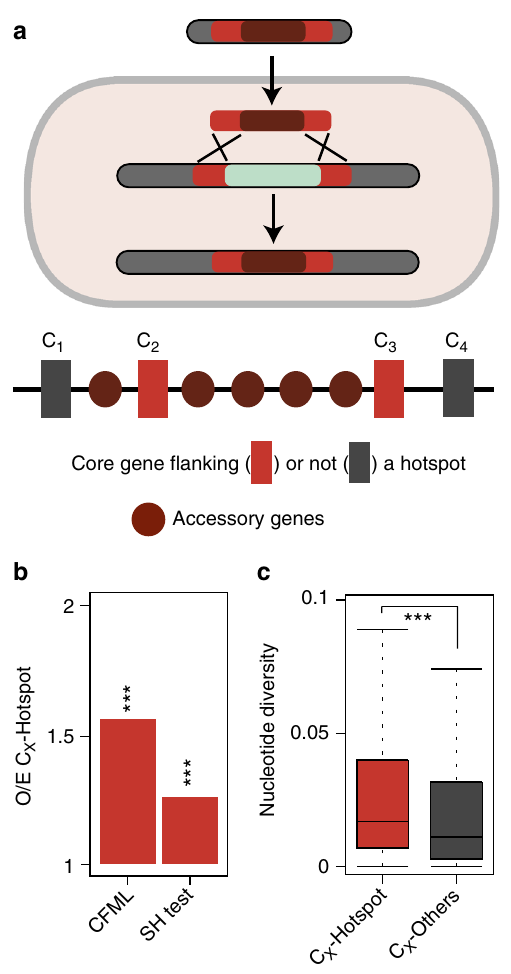
Fig. 8 Evidence for more frequent homologous recombination in core genes fl anking hotspots than in the other core genes. a Model for the creation and evolution of hotspots by homologous recombination at the fl anking core genes. b We detected homologous recombination events in the core genes using ClonalFrameML, and searched for evidence of phylogenetic incongruence ( P < 0.05) between each core gene family and the whole core genome tree of the clade using the Shimodaira – Hasegawa (SH) test. The observed – expected ratios (O/E) for these two analyses are signi fi cantly higher than one. *** P < 10 − 3 ; χ 2 -test. c Differences in nucleotide diversity between core genes fl anking hotspots and the others. Nucleotide diversity was calculated using the R package “ PopGenome ” v2.1.6 49 by implementation of the diversity.stats() command. *** P < 10 − 3